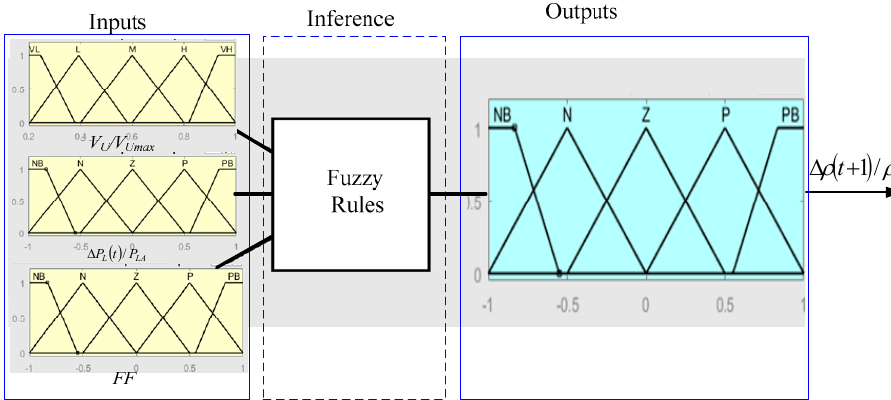
Figure 6. The structure of FLC.